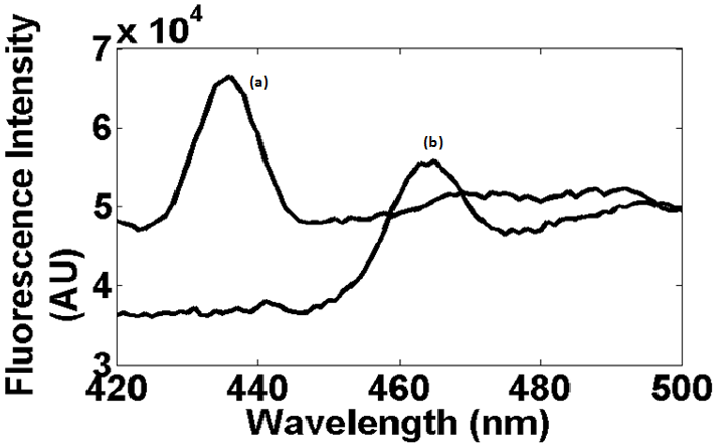
Figure 4. Fluorescence spectra of ( a ) wsMWCNTs and ( b ) GNP conjugated wsMWCNTs.